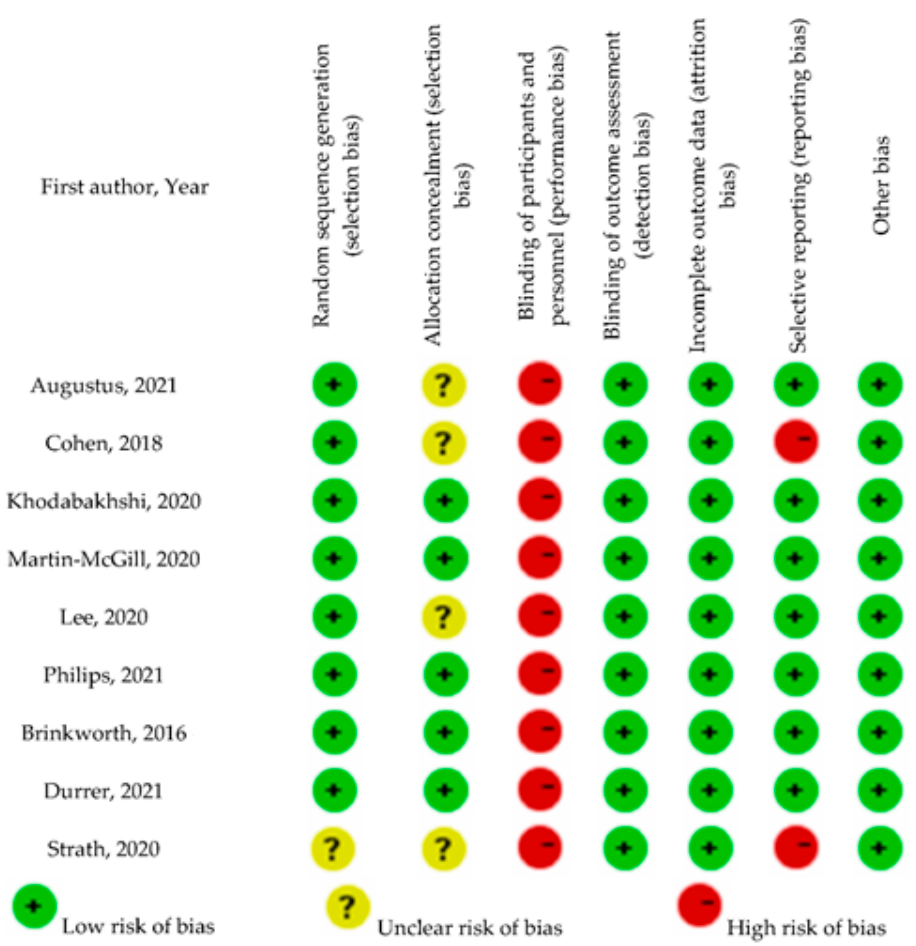
Figure 2. Risk of bias of included studies from consensus between a pair of raters [36–44].